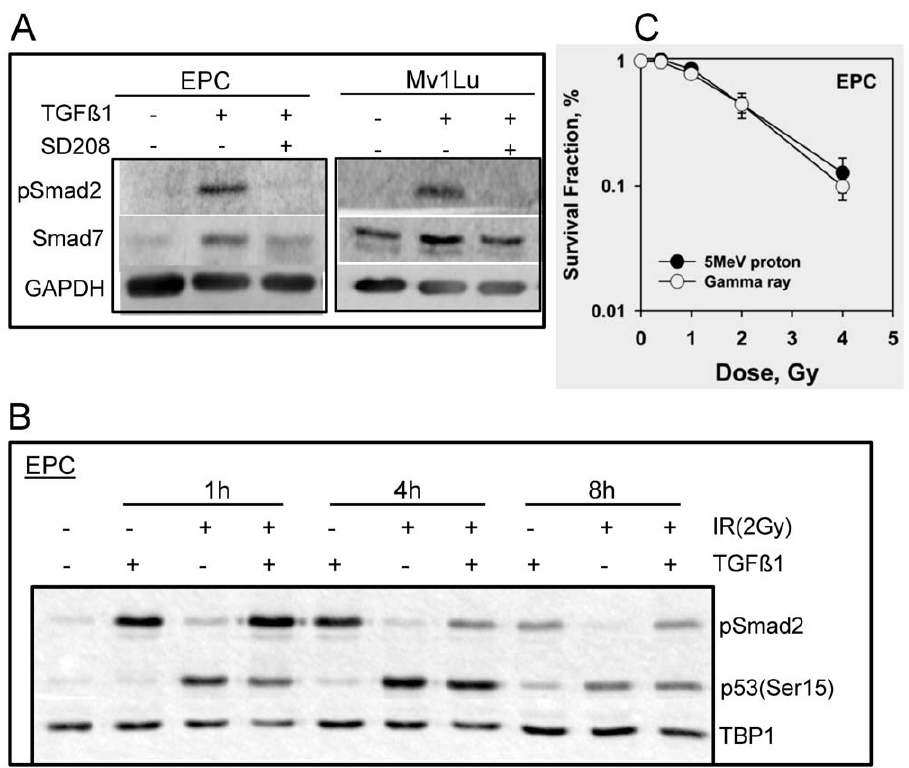
Figure 1. Cellular response to TGF b 1 and IR exposure in EPC and Mv1Lu cells. A. Whole cell extracts were prepared 4 h after 2 ng/ml TGF b 1 treatment using M-PER kit. Phosphorylation of Smad2 and expression of Smad7 were detected using western blotting. TGF b R1 inhibitor- SD208 (or DMSO as control) was added one hour prior to the addition of TGF b 1. GAPDH was used as loading control. B. Nuclear extracts were isolated from EPC cells using NE-PER kit after 2 Gy of proton radiation at indicated times, in the presence or absence of TGF b 1. Shown are the western blots with phosphorylation of Smad2 and p53, and TBP1 as internal loading control. C. Clonogenic survival assay of EPC cells with different doses of protons and gamma rays as described in Materials and Methods.